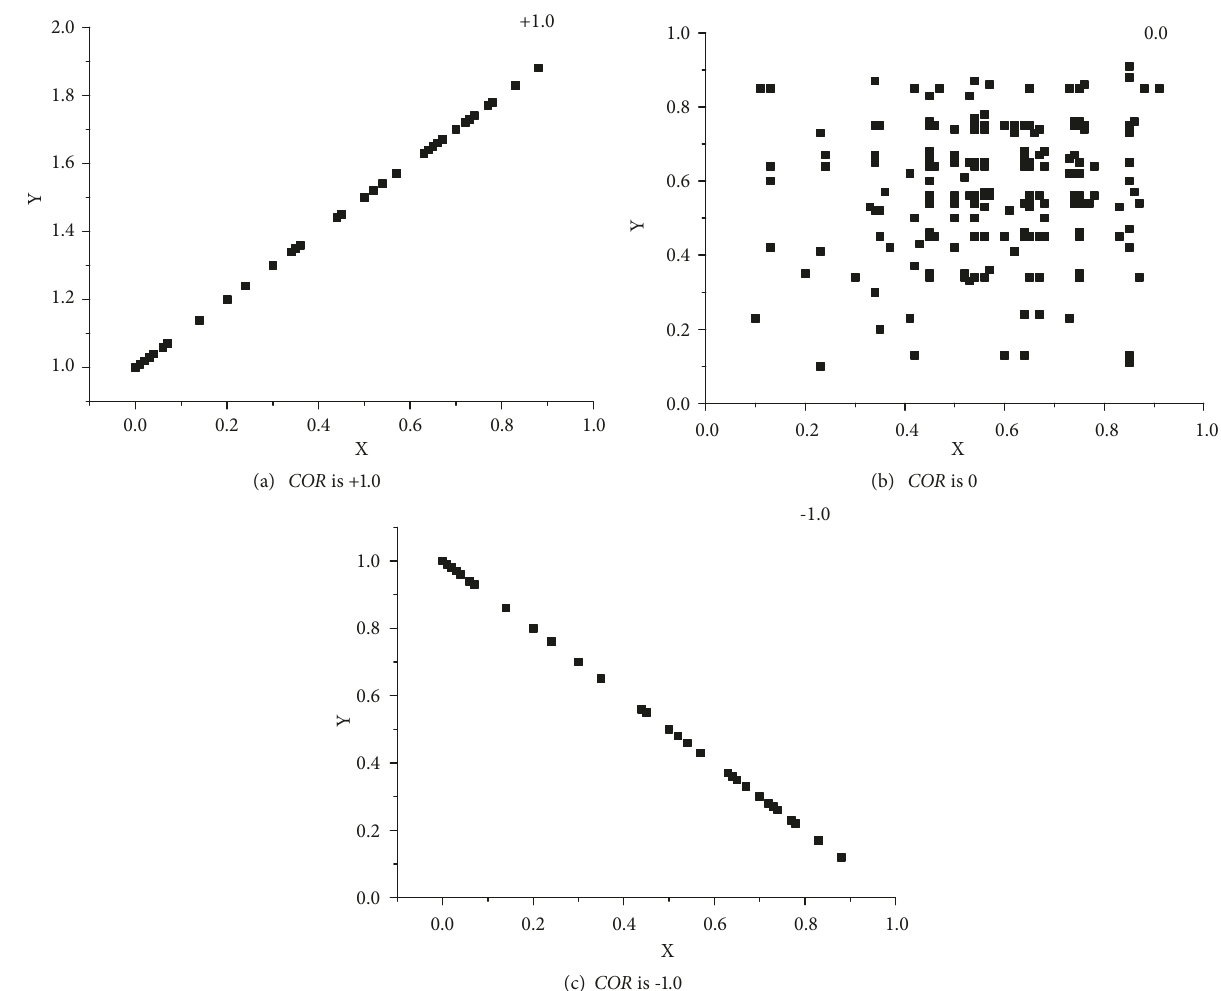
Figure 2: The coefficient COR of different consumption